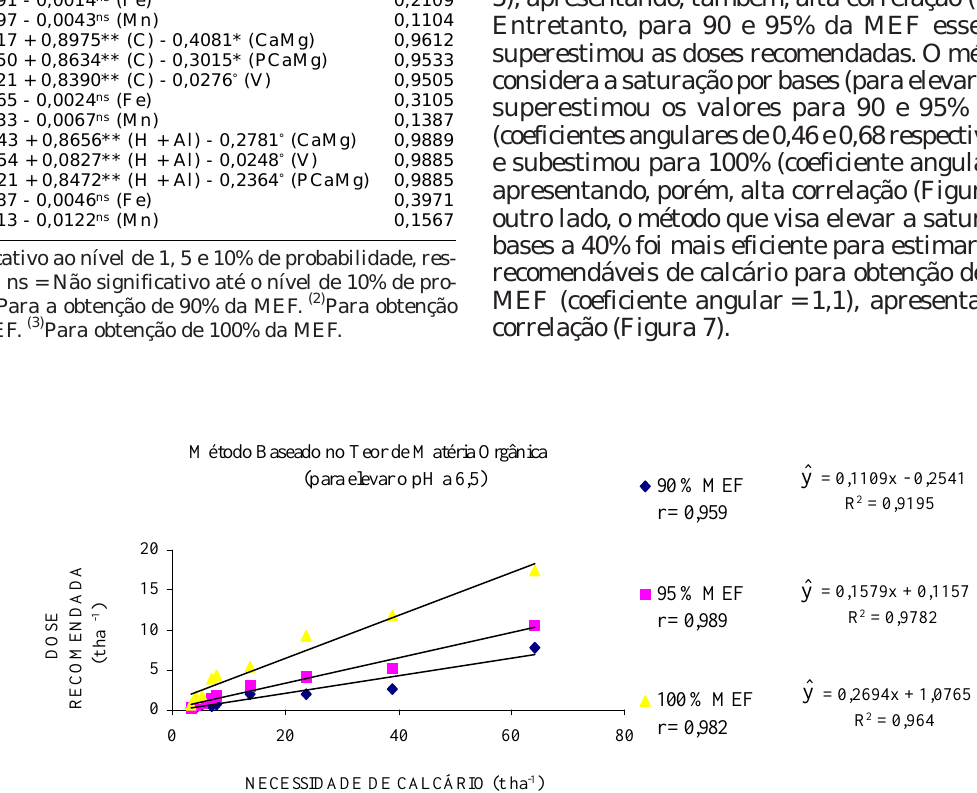
Figura 1. Relação entre as necessidades de calcário, pelo método que considera o teor de matéria orgânica (para elevar o pH a 6,5), e as doses recomendadas de calcário para obtenção de 90, 95 e 100% da máxima eficiência física (MEF) .